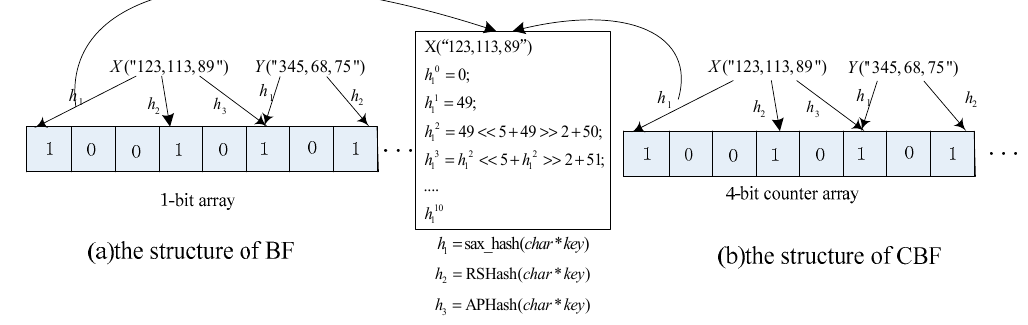
Figure 1. Structure of high-dimensional vector Bloom filter.